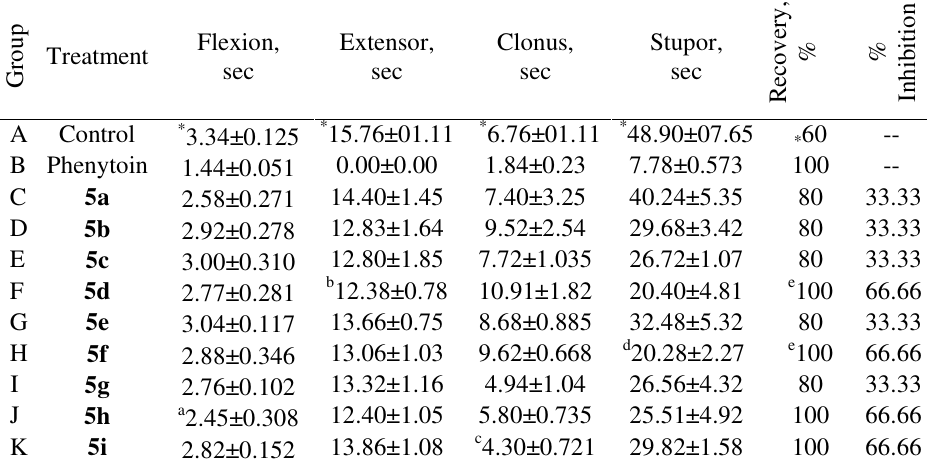
Table 2. Anticonvulsant effect of different pyridazinone